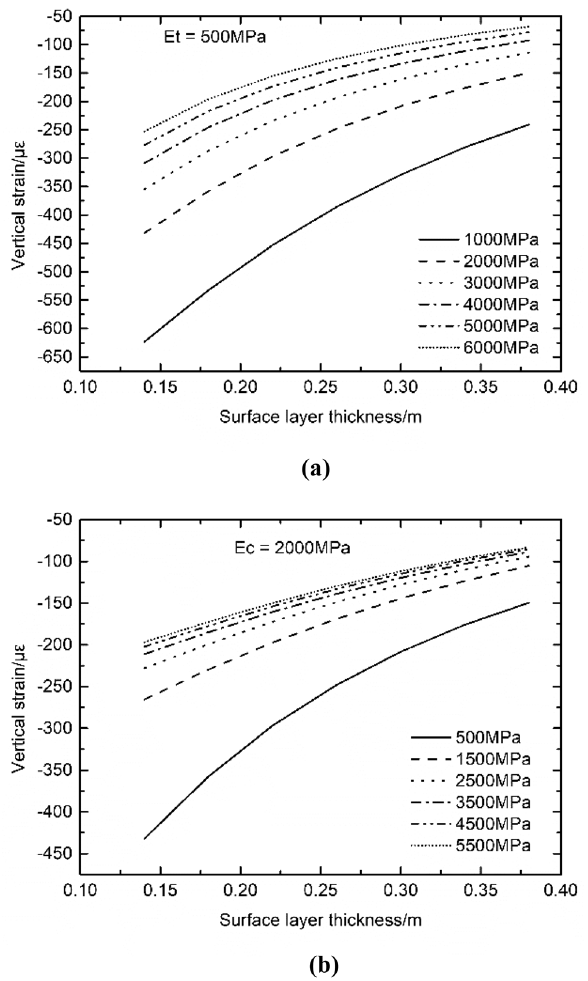
Fig. 6 Response of vertical compressive strain under the influence of a the thickness and modulus of the pavement (equivalent resil- ient modulus on top of the base was 500 MPa), and b the thickness of the pavement and equivalent resilient modulus on top of the base (modulus of the pavement was 2000 MPa)